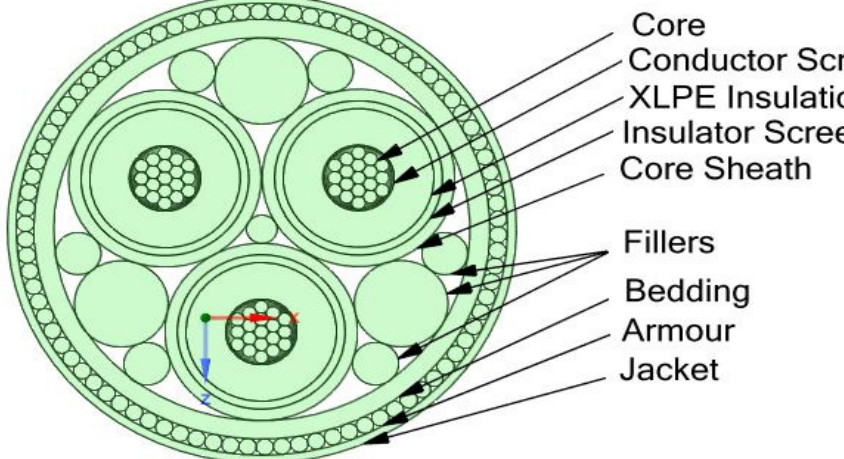
Figure 1. Cross-section of the